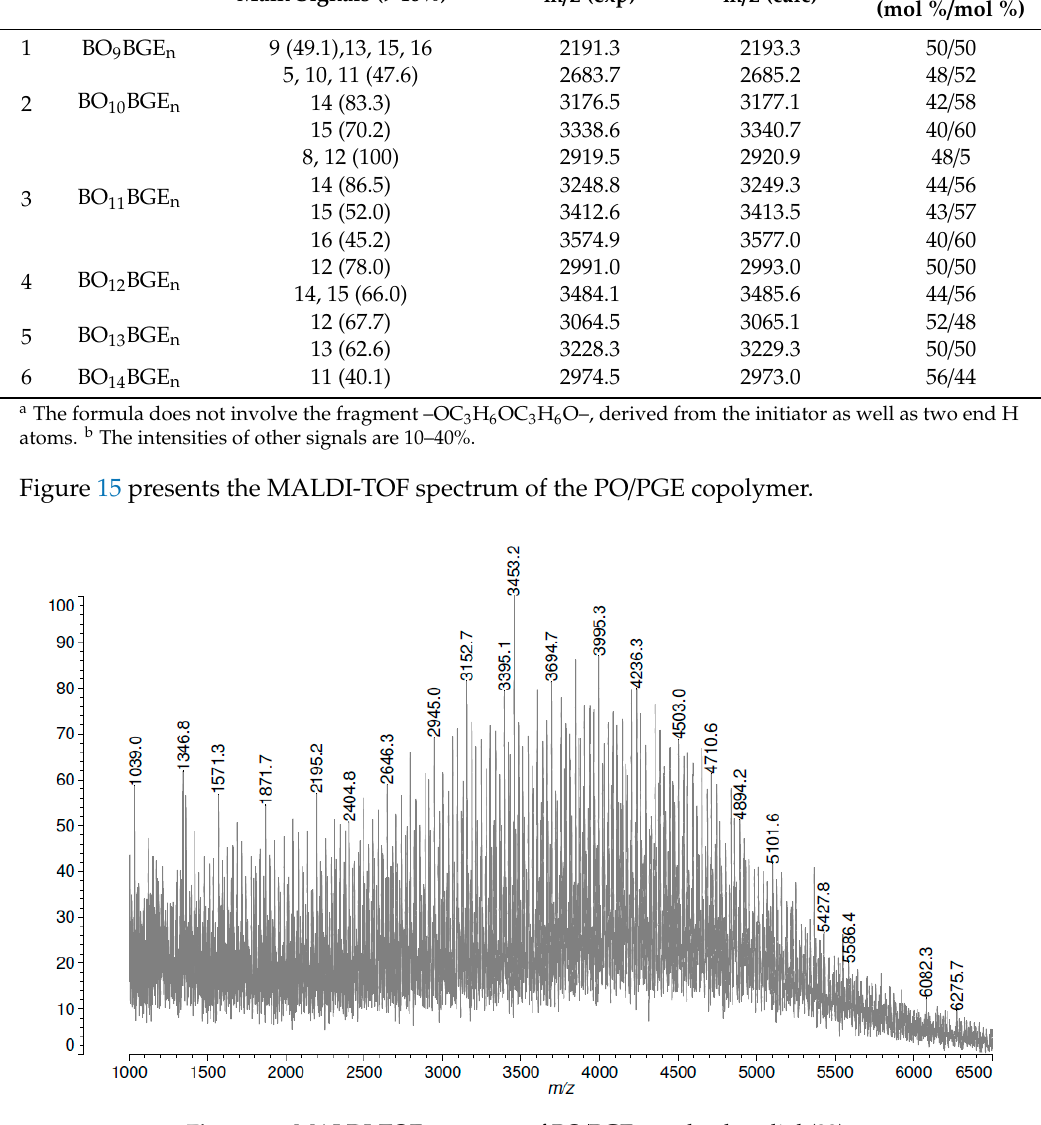
Figure 15. MALDI-TOF spectrum of PO/PGE copolyether-diol (22).